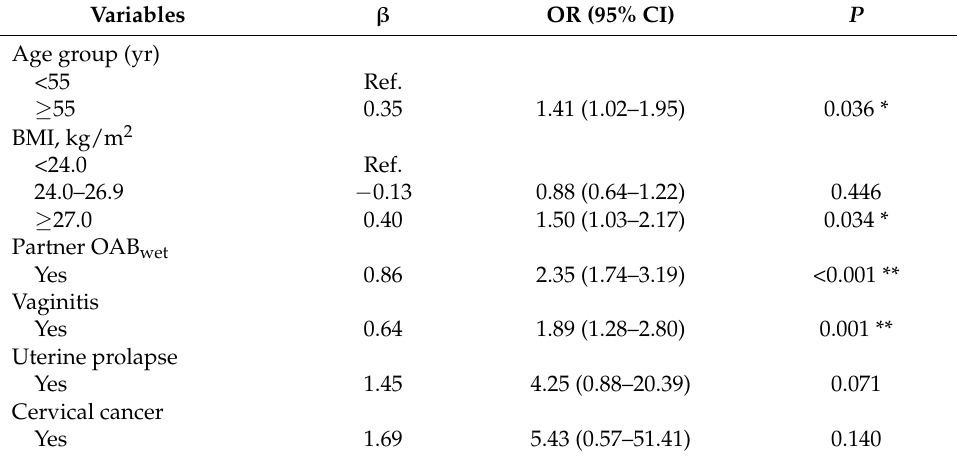
Table 3. Associated factors for the OAB wet in middle-aged